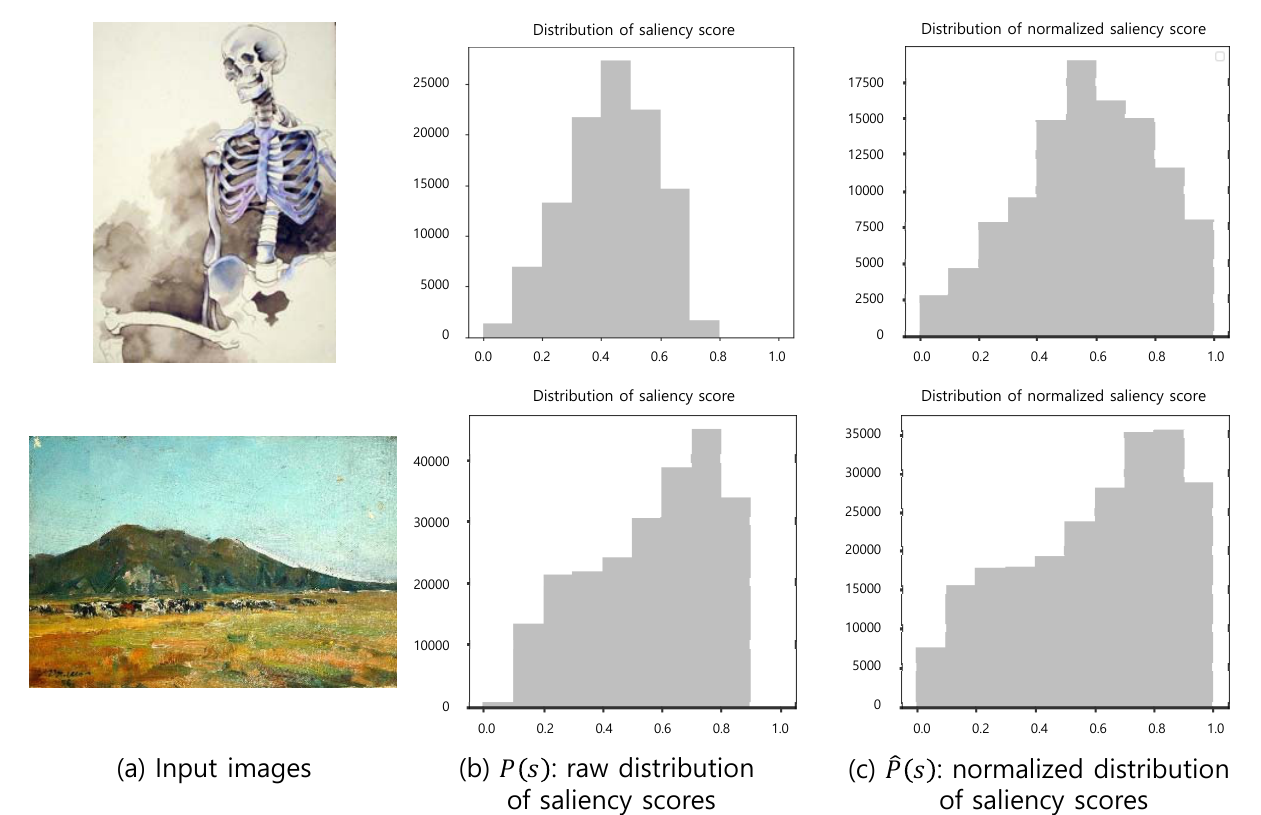
Figure 6. The normalized distributions of saliency scores for input images.